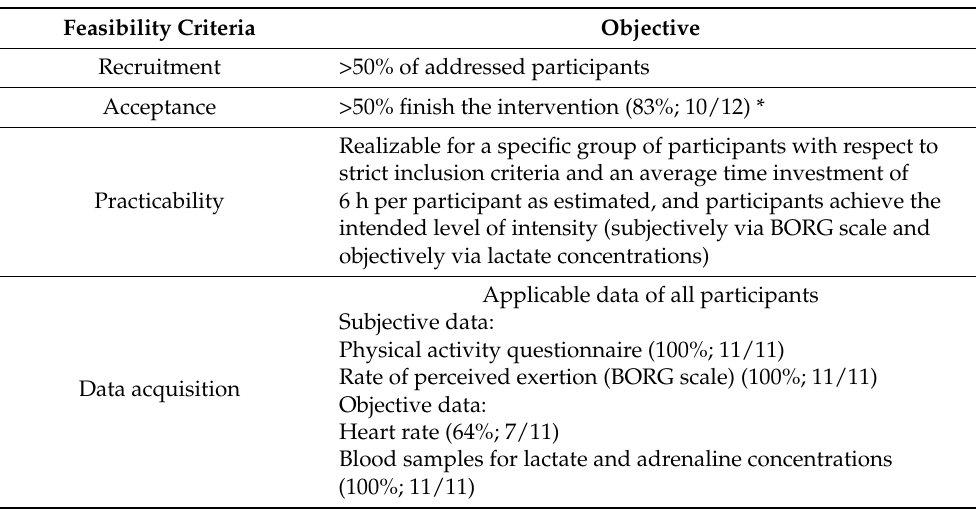
Table 2. Feasibility criteria and rate of fulfillment.